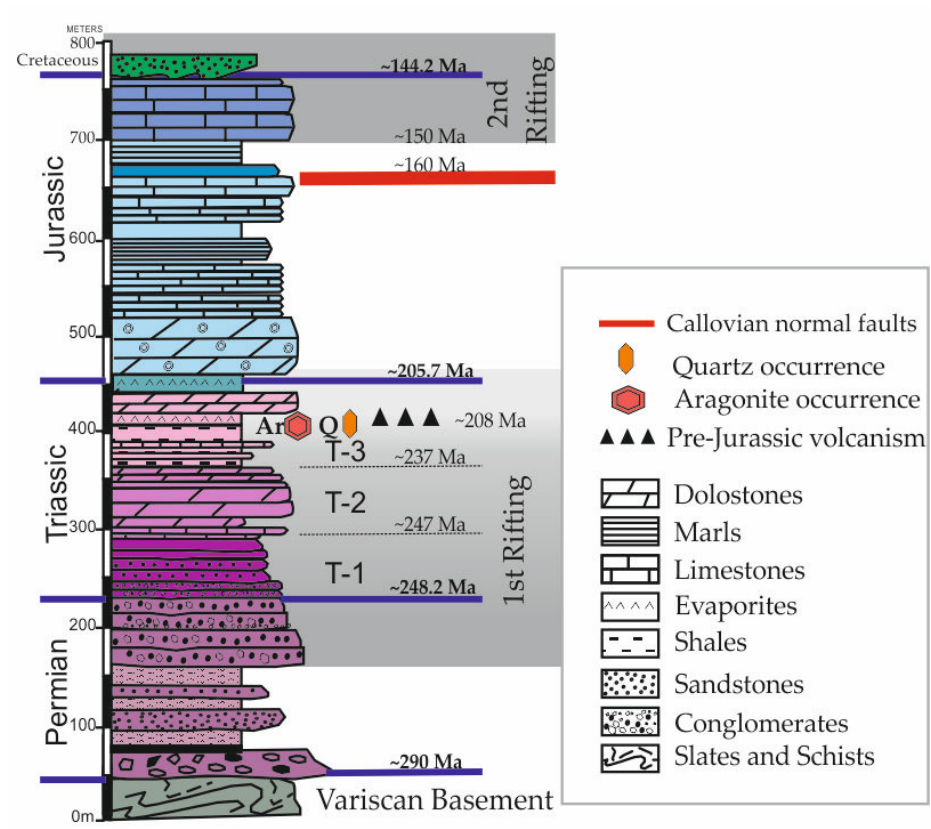
Figure 2. Upper Permian to Lower Cretaceous stratigraphic section in the Iberian Basin (lithology, thickness, and ages) and position of the occurrences of aragonite (Ar) and authigenic quartz (Q). Dates of the pre-Hettangian volcanism and the 1st and 2nd Rifting periods are indicated [32] (T-1: Buntsandstein; T-2: Muschelkalk; T-3: Keuper; Modified from [1].